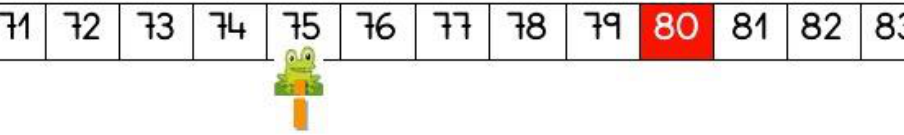
Figure 28. Saltarina is on 75.